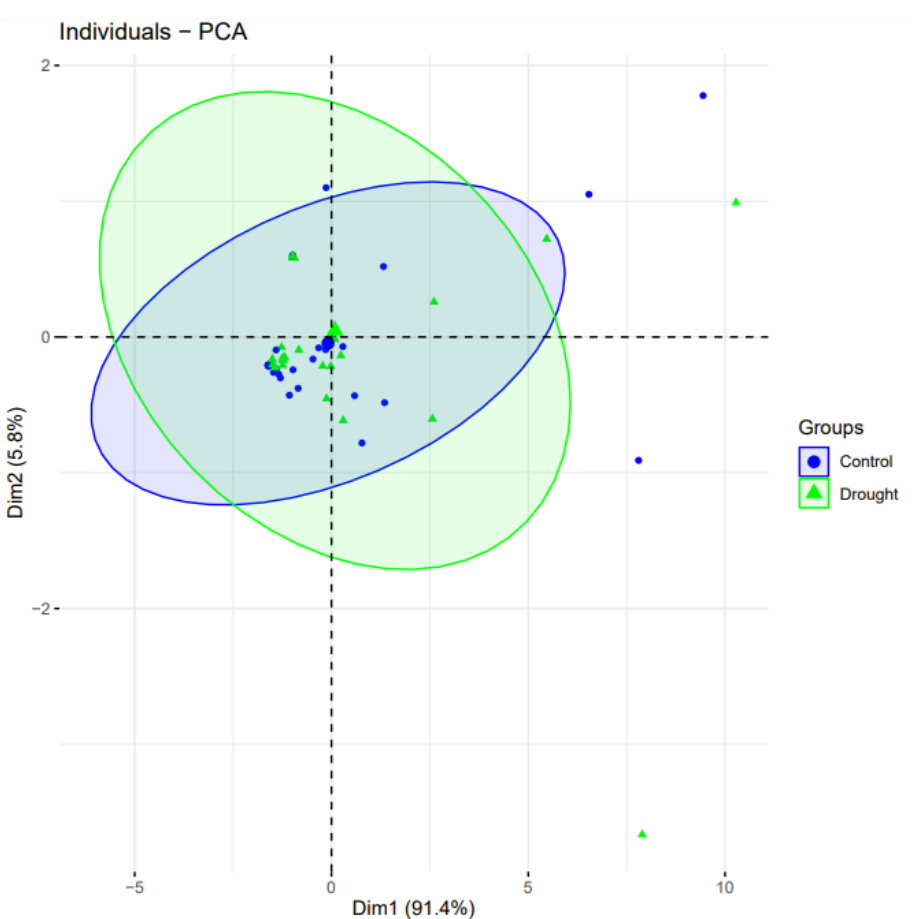
Figure 5. Principal component analysis biplot of gene expression of 11 genes studied in well-watered and drought conditions. PCA plot reveals the variation in the form of principal components (PC) 1 and 2. PC1 and PC2 drawn as Dim1 and Dim2 on horizontal and vertical axis, respectively, accounting for the variation up to 91.4% and 5.8%, respectively. Same genes are placed in plot based on their expression in drought and control conditions.